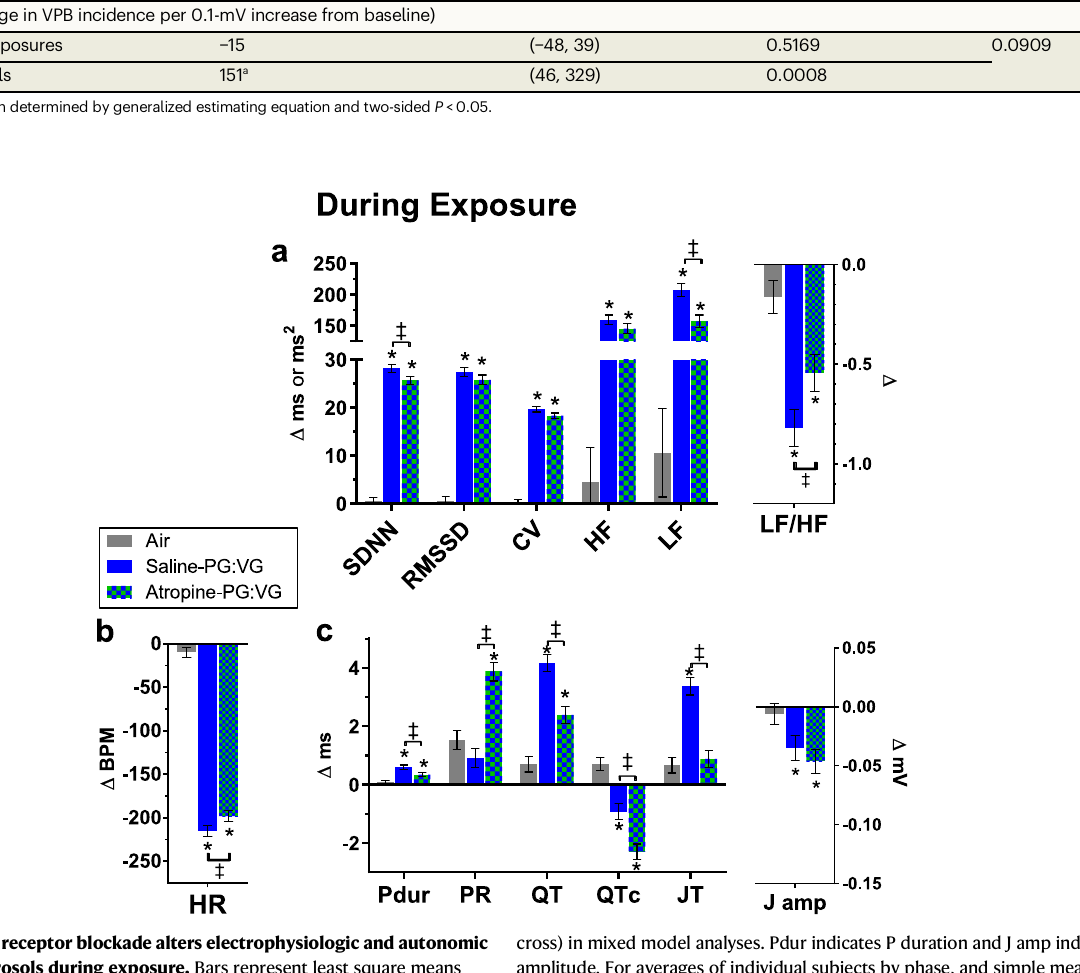
cross) in mixed model analyses. Pdur indicates P duration and J amp indicates J amplitude. For averages of individual subjects by phase, and simple means and standard errors, seeSupplementaryFigs. 15 – 17.Source data, including all p values, are provided as a Source Data fi